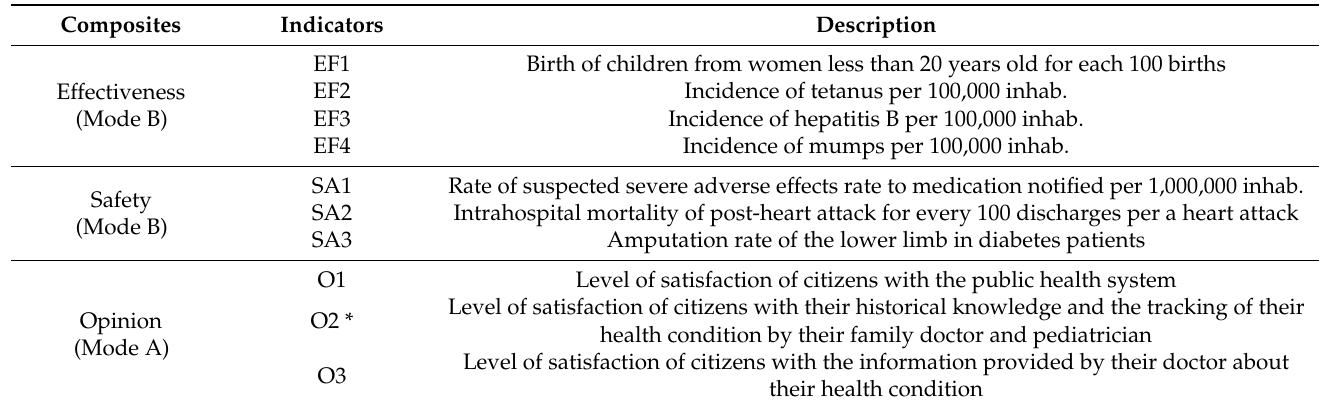
Table 1. Composites and description of